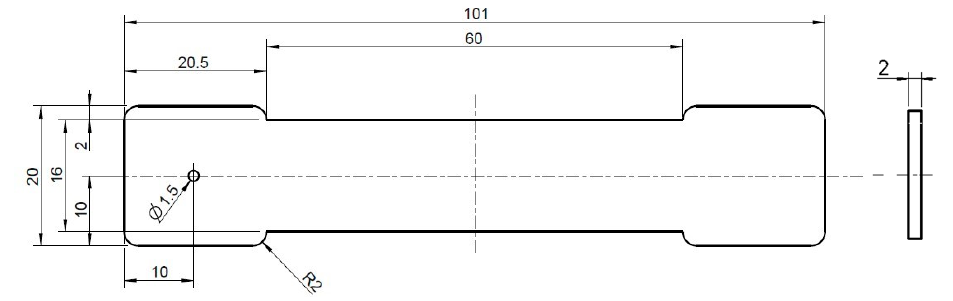
Figure 1. Schematic representation of the produced specimen with point gate of the hot runner systems. Table 3. Process temperatures of injection molding.